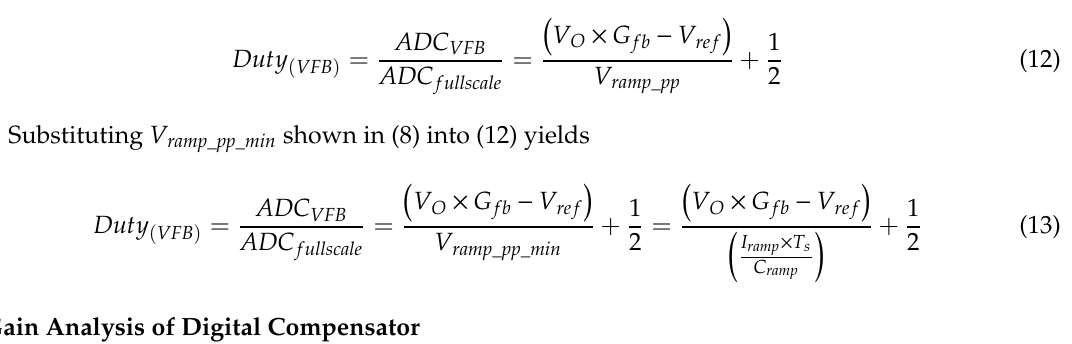
(cid:19) V ramp _ pp ; ( b ) v (cid:48) 2